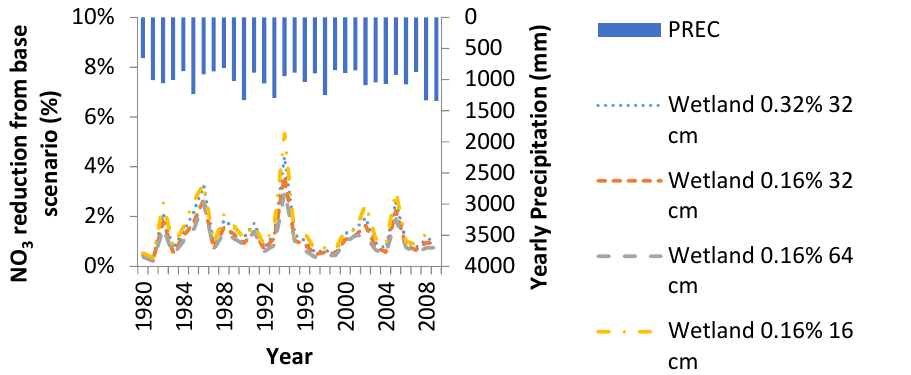
Figure 8. Nitrate load reduction in outlet flow for different wetland configurations compared with no wetland.